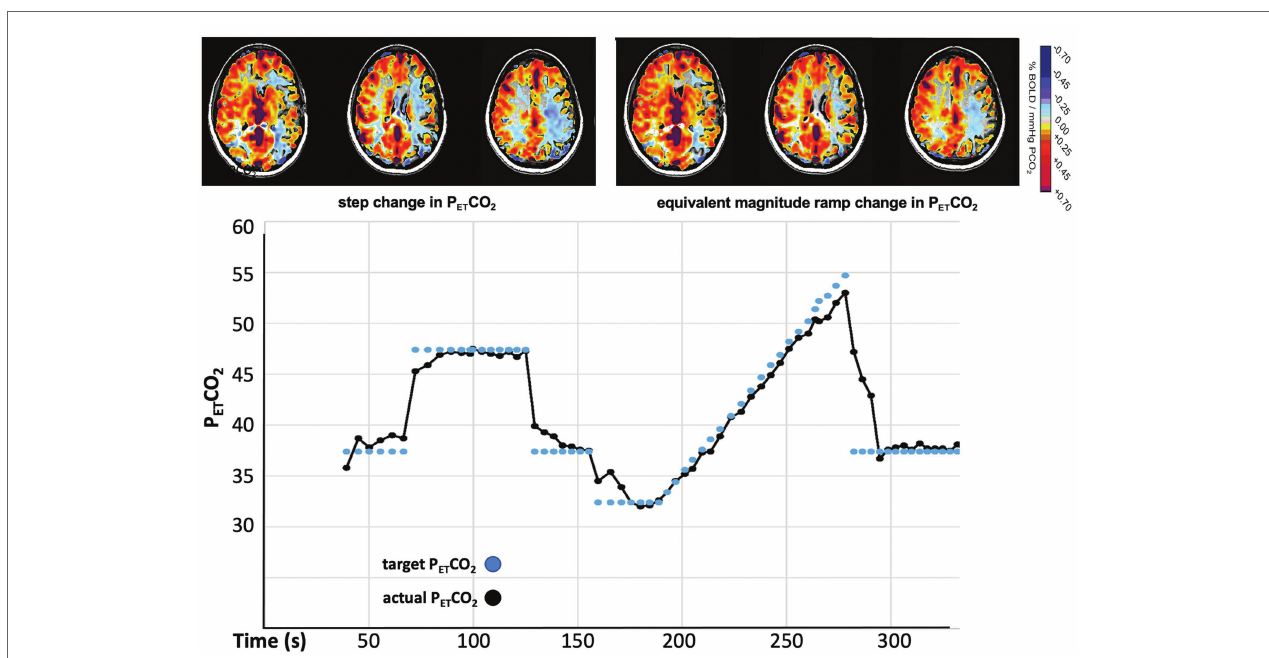
FIGURE 8 | CVR measured with a step (“box car”) change and a ramp change of P ET CO 2 in a patient with moyamoya disease. The calculation of CVR after the step change indicates extensive bilateral “steal.” The gradual ramp stimulus shows much reduced steal (less blue). These maps indicate that, if not accounted for, slowed response times contribute to the reduced values in the calculation of the CVR.